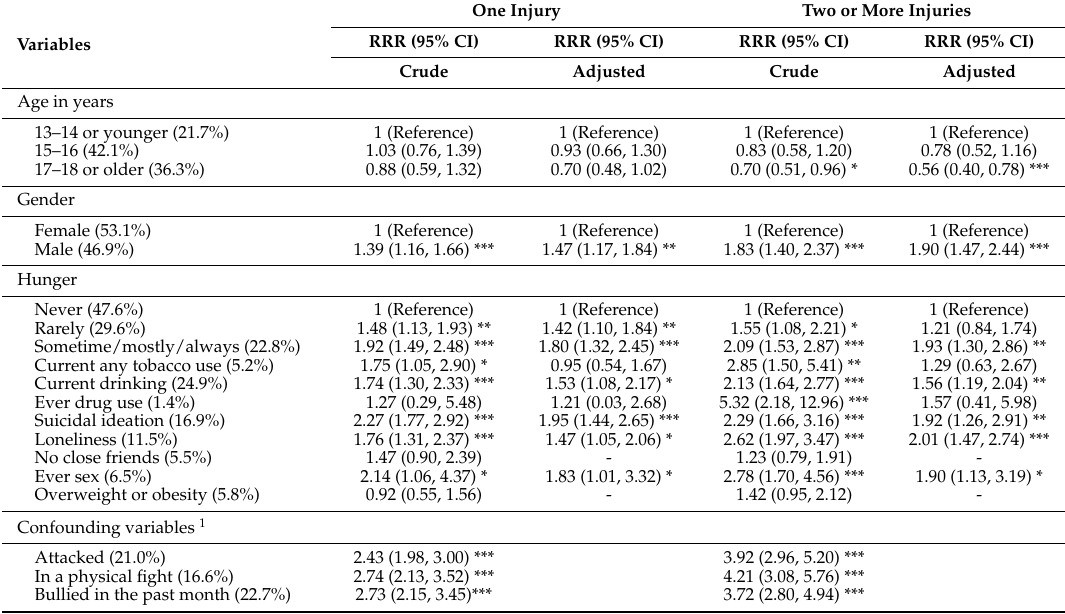
Table 5. Relative risk ratios and 95% confidence intervals from a multinomial logistic regression model predicting one injury and two or more with injuries in